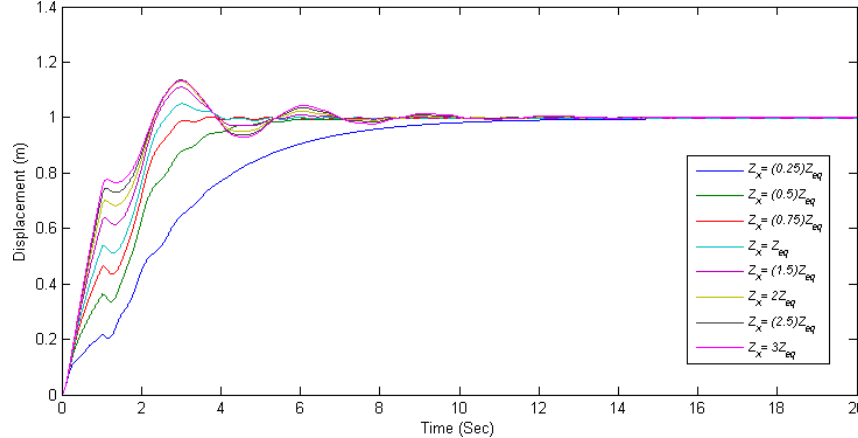
Figure 9. Trolley response to 1m x direction input with di ff erent Z values in the WBC.